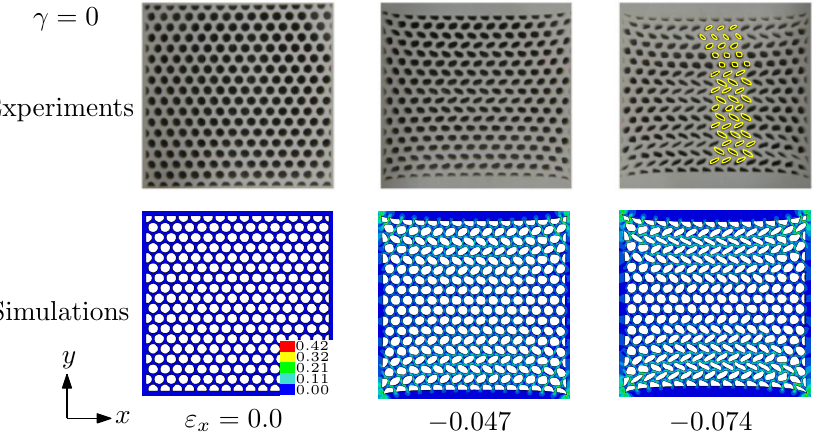
Figure 3. Deformed morphologies of specimen 1 at different applied strains (0%, respectively) for biaxiality ratio γ = 0 (uniaxial compression) predicted by the simulations and the experiments. The color bar shows the effective strain of the